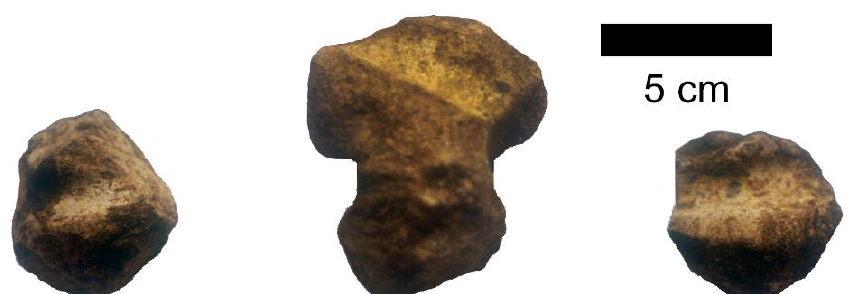
Figure 6. Marolles-sur-Seine “le Chemin de Sens”: grooved abraders found with shell bead roughouts in the refuse of a workshop in a pit along an early Neolithic